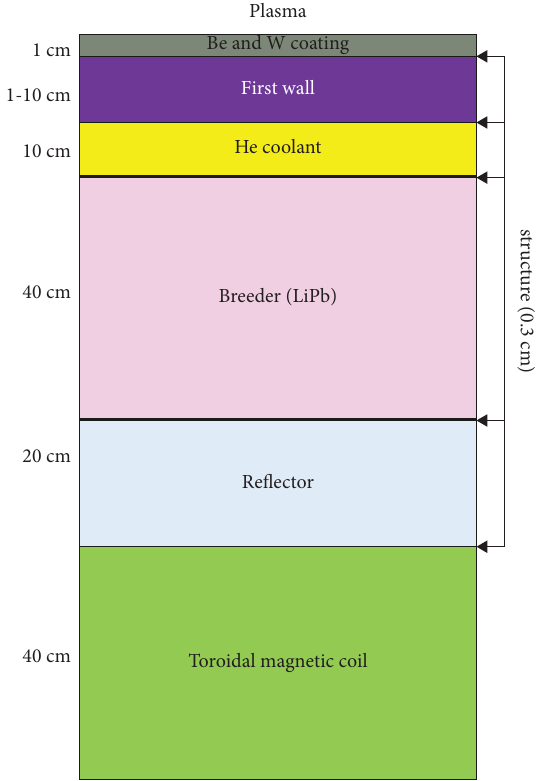
Figure 2: Blanket confguration from plasma to